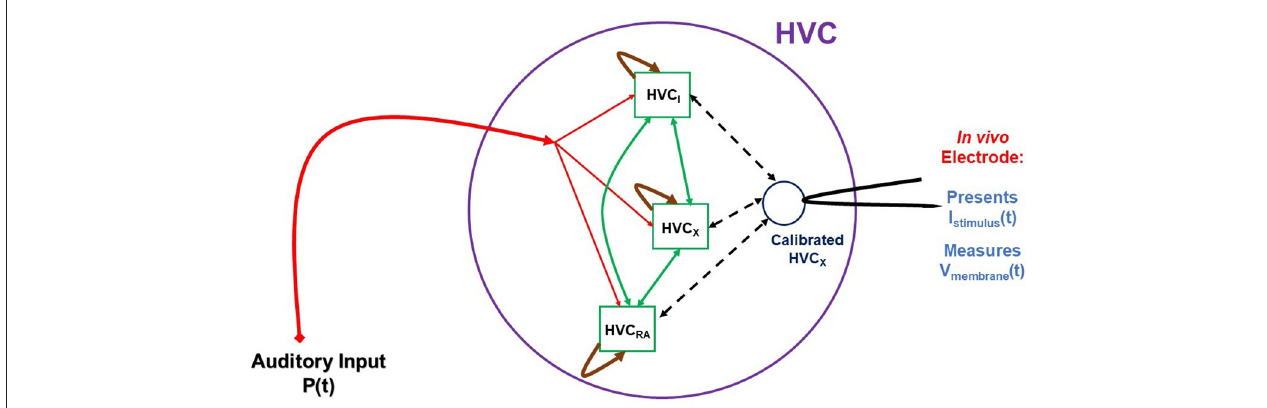
HVC X , HVC I , HVC RA neurons are { }